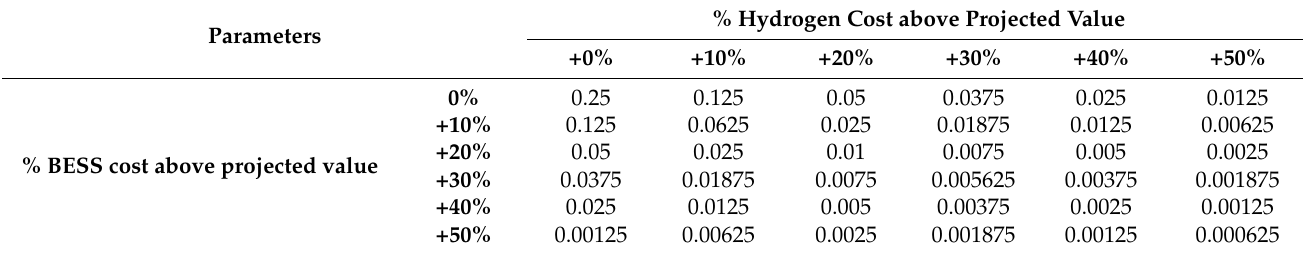
Table 4. Joint probability density function for BESS and hydrogen cost uncertainties.